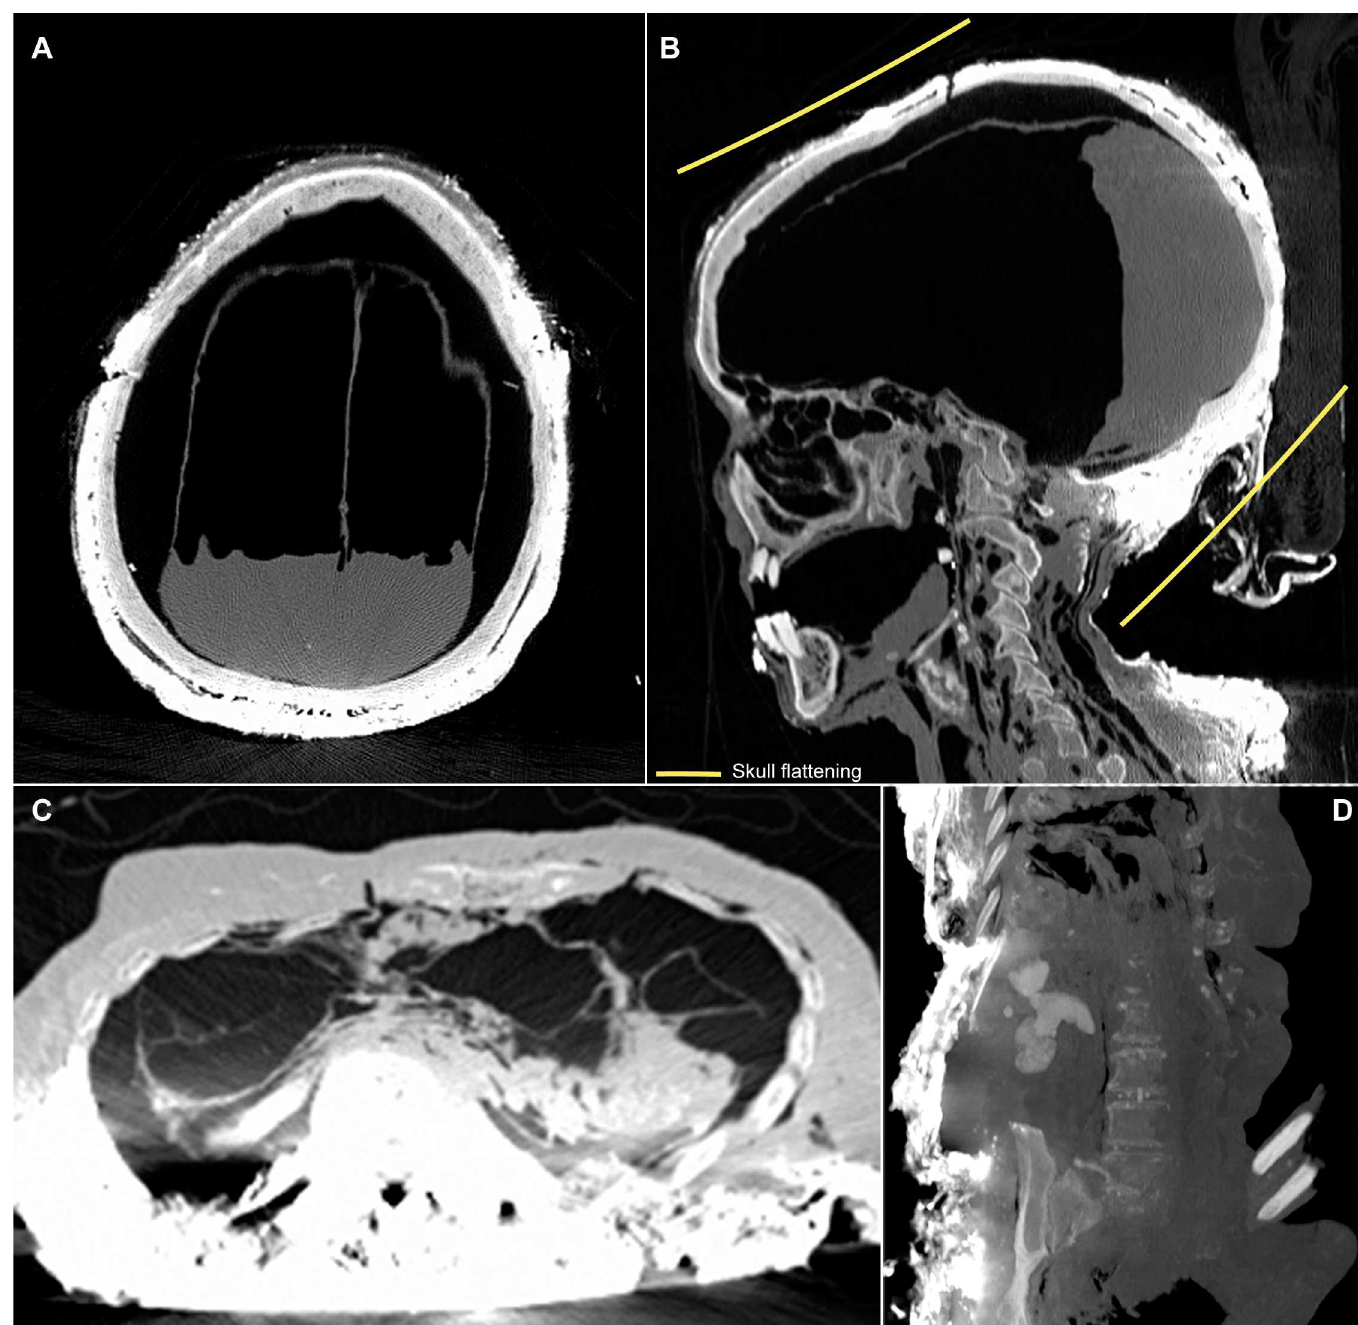
Fig 9. Tomodensitometric examination. (A) The meningeshad fallen and begun decomposingbut the cerebralparenchyma resting against the posterior section of the craniumis still visible (Skull axial plan). (B) Skull and cervical vertebrae sagittal plan showingevidenceof intentional cranialdeformation. (C) The pericardialsac is empty. The hyperdense aspect of the posterior thoracic soft tissues as well as the bone structures are visible(axial plan). (D) Dense kidney stones are visible on the abdomino-pelvic coronal